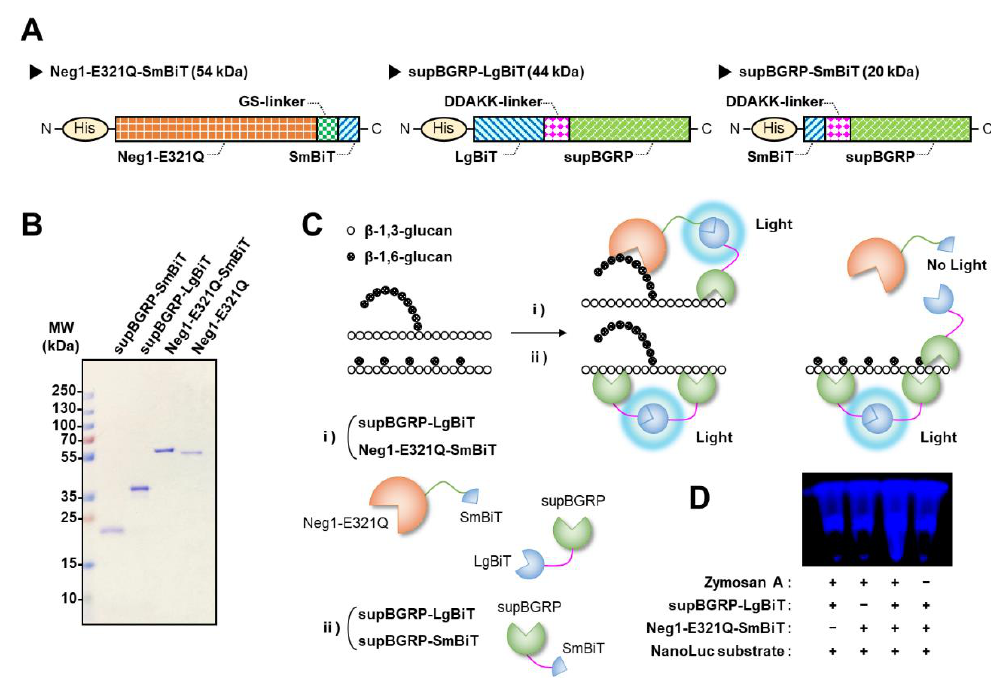
Figure 1. Split-NanoLuc complementation assay for β-glucan. ( A ) Diagram of Neg1-E321Q-SmBiT, supBGRP-LgBiT, and supBGRP-SmBiT. ( B ) SDS-PAGE image of supBGRP-SmBiT, supBGRP-LgBiT, Neg1-E321Q-SmBiT, and Neg1-E321Q. Purified recombinant proteins were separated using a 12% polyacrylamide gel under nonreducing conditions and identified by Coomassie Brilliant Blue staining. ( C ) Schematic illustration of the split-NanoLuc complementation assay for β-glucan. ( D ) Validation of sensor for β-1,6-branched β-1,3- D -glucan by bioluminescence imaging. Zymosan A (50 μg/mL, 40 μL) was mixed with split-NanoLuc-fusion proteins (800 nM each, 10 μL) and furimazine solution (60 μL) in microtubes.